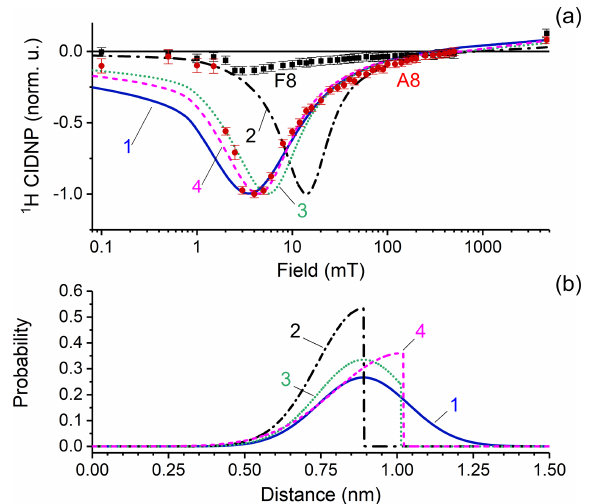
Figure 7. (a) CIDNP dependence on the magnetic field. Red cir- cles and black squares represent experimental data for adenine A8 and flavin F8 protons; CIDNP data corrected by taking into account nuclear relaxation occurring during sample transfer to the detec- tion position at high field. Lines show the numerical simulation of CIDNP field dependences with the parameters listed in Table 1, using four different distance distribution functions which are de- picted in panel (b) . The fit quality is characterized by the q value that is the sum of squared deviations from the experimentally ob- served data. The q values are 1.8 × 10 − 3 , 9 × 10 − 3 , 5.2 × 10 − 3 , and 3.9 × 10 − 3 for simulations 1–4, respectively. (b) Model birad- ical end-to-end distribution functions used for simulations of the CIDNP field dependence: simulation 1 (blue solid line) – normal distribution centered at 0.89nm with standard deviation 0.15nm; simulation 2 (black dashed-dotted line) – left half of normal distri- bution centered at 0.89nm with standard deviation 0.15nm; simula- tion 3 (green dotted line) – normal distribution centered at 0.89nm with standard deviation 0.15nm, with distances above 1.03nm cut; and simulation 4 (magenta dashed line) – left half of normal distri- bution centered at 10.2nm with standard deviation